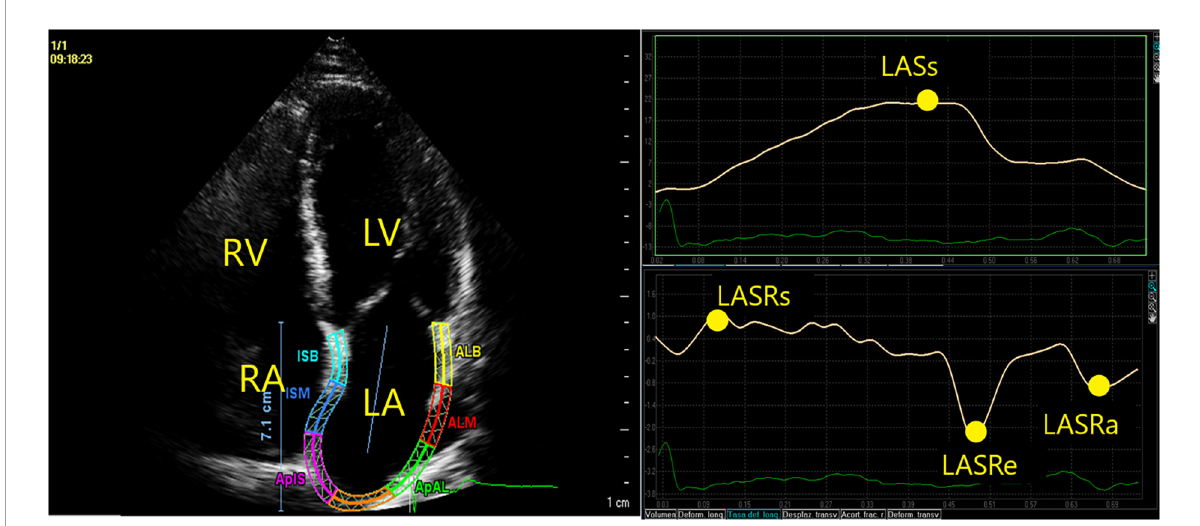
FIGURE1 Endocardial border was automatically traced with speckle tracking. LASs l , representing LA reservoir function, was identified as the peak positive strain value during LV systole. In the LA strain rate curve, we identified the peak positive strain rate (LASRs l ) at the beginning of LV systole, the peak negative strain rate during early diastolic (LASRe l ) strain rate, representing conduction function and late diastolic (LASRa l ) strain rate after the P-wave on the electrocardiogram, representing LA active contraction.